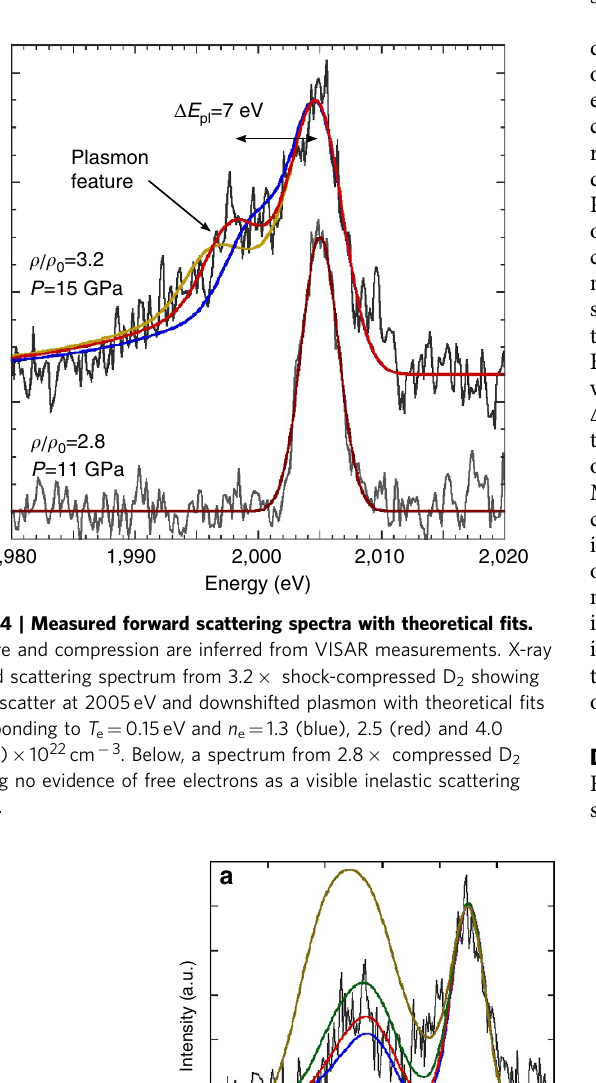
density inferred from the VISAR trace, this corresponds to an average ionization state of Z ¼ 0.15 ± 0.04. The measured electron density corresponds to a Fermi temperature of T F ¼ 3.1 eV. For typical temperatures of a fraction of an electron volt, the electrons are therefore strongly degenerate, with y ¼ kT = e F (cid:4) 0 : 1, and a scattering parameter of a ¼ 1.5.